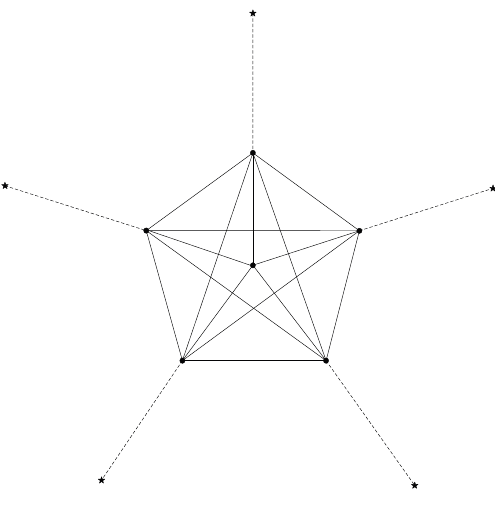
Figure 1. The token trapped by a high-density